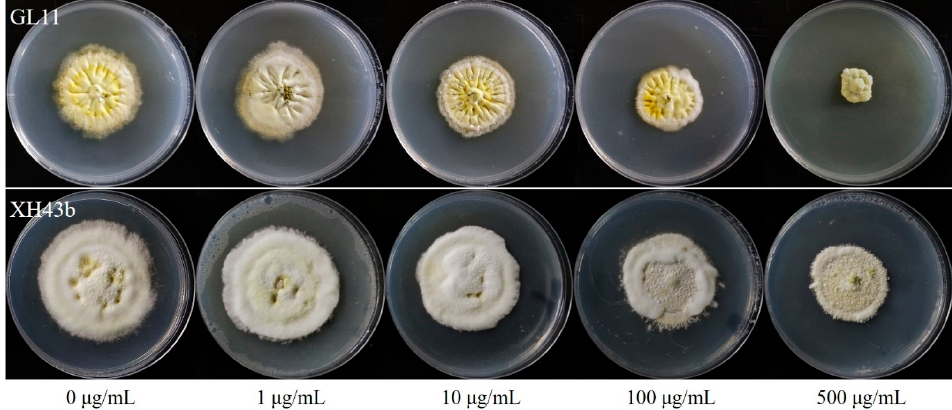
Figure 4. Sensitivity of resistant isolates GL11 and XH43b to carbendazim after 5 transfers (T5) on fungicide-free PSA. Photos were taken after 28 days of incubation at 27 °C in the dark. Table 2. Stability of resistant Ustilaginoidea virens isolates to carbendazim.